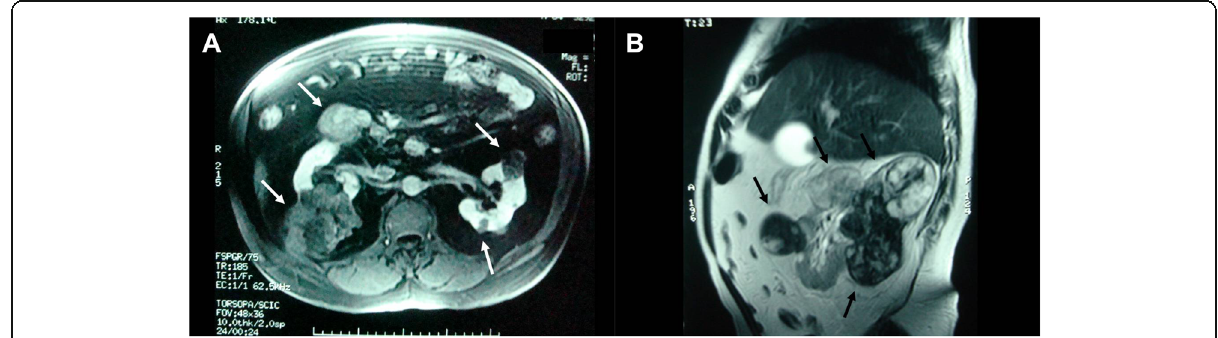
Fig. 3 Magnetic resonance imaging (MRI) of the abdomen. a T1-weighted image with fat suppression after venous administration of the contrast medium. Several expansive formations can be observed in both kidneys with less intense enhancement than that of the adjacent renal parenchyma (white arrows). b T2-weighted image of the sagittal section of the right kidney. The black arrows show multiple expansive heterogeneous signal formations, with hyposignal and hypersignal areas in T2-weighted sequences and a 10-cm lesion in the lower pole of the right